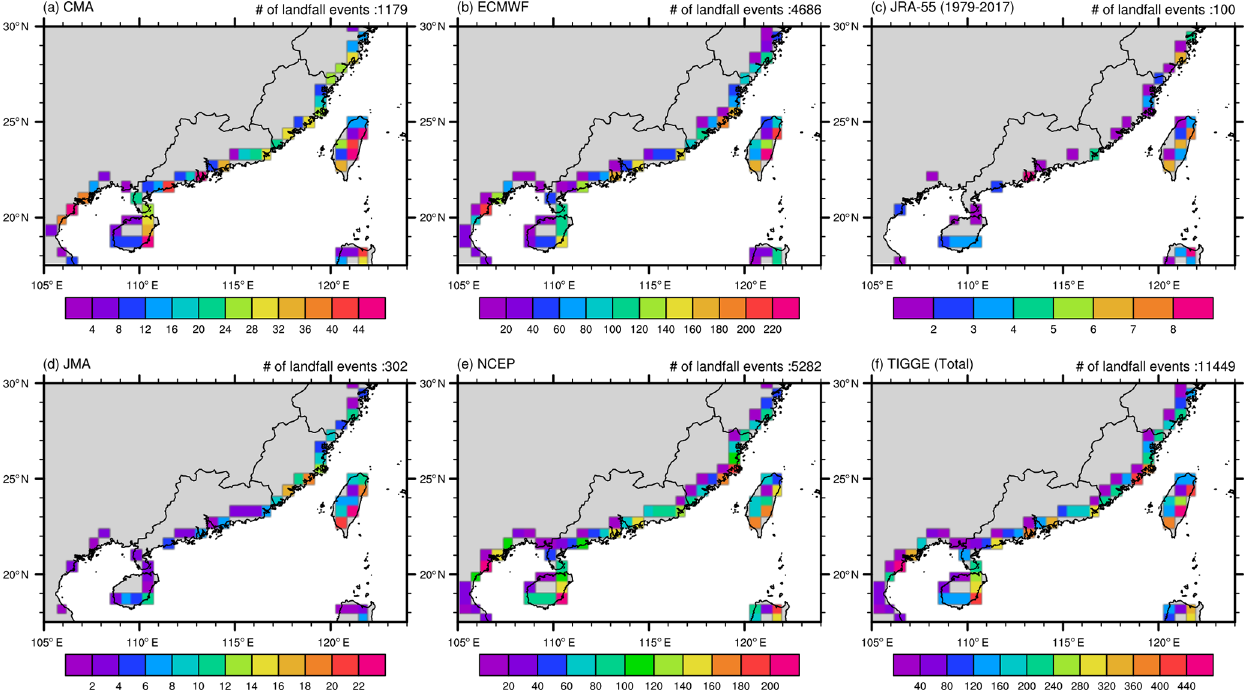
Figure 9. Spatial distribution of the number of landfall events (landfall with at least typhoon strength) for the TPEPS TC event set and the JRA-55 event set (colours). The total number of landfall events in each panel is shown in the top right of each panel.